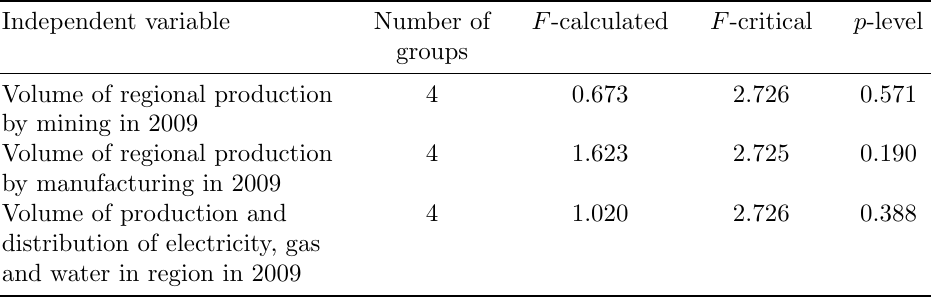
Figure 6: Most energy intensive Russian regions (kg of fuel equivalent per 10 thousand rubles in 2010) Table 2: The results of